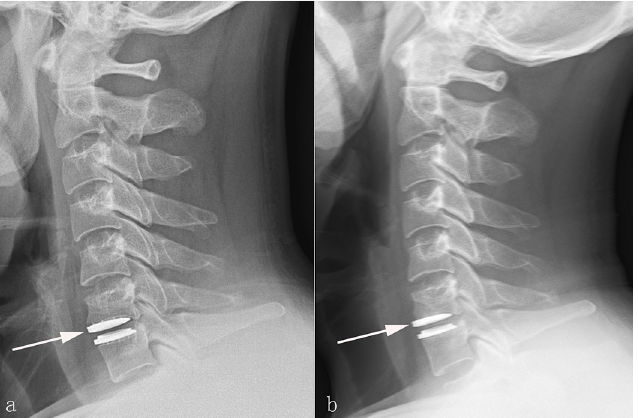
Fig 2. The representive case who suffered migration of Discover prothesis postoperatively. Postoperative 2-day (a), and final follow-up (b) lateral radiographs showing anterior migration of the superior endplate of Discover prosthesis (White arrows).